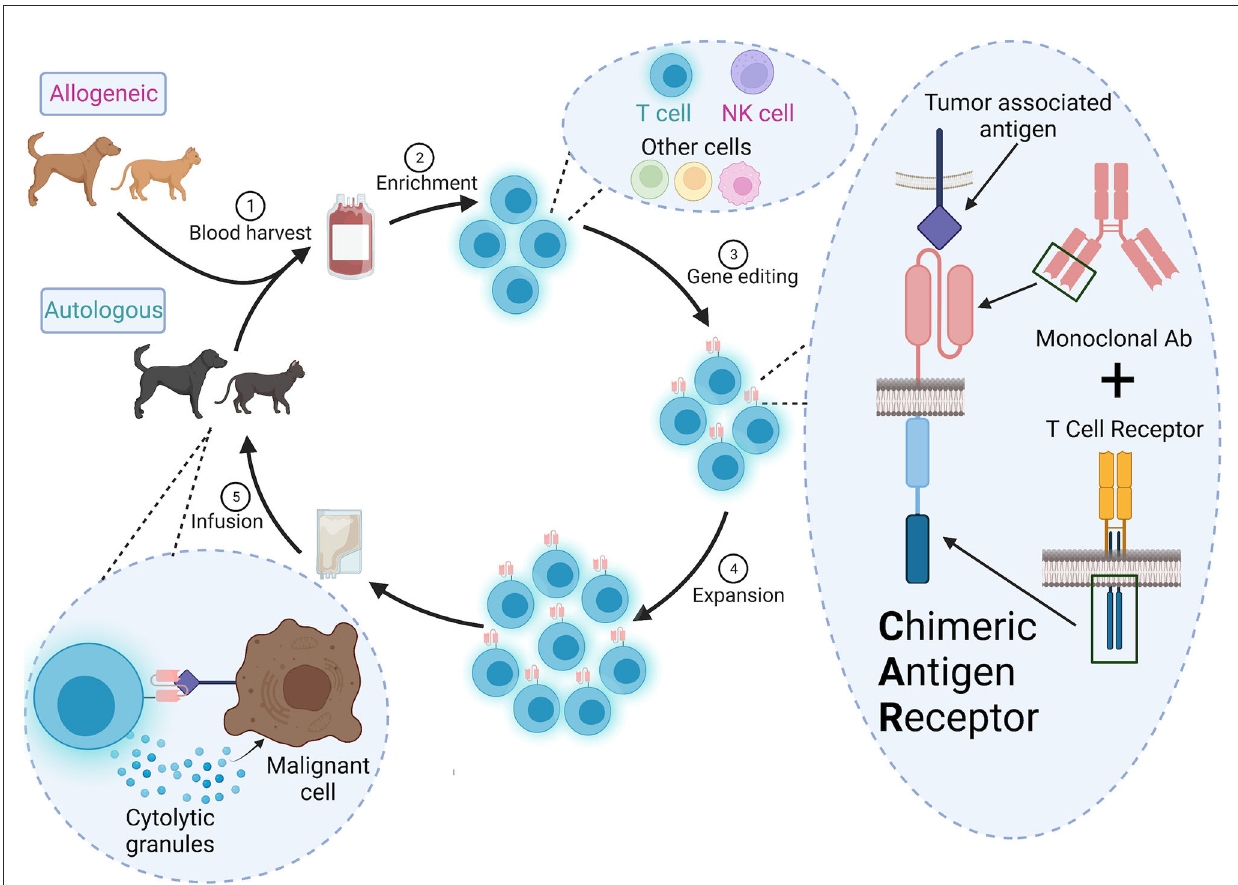
FIGURE1 Overall scheme for CAR therapy in veterinary medicine. (1) Autologous (from the patient) or allogeneic (from a donor) cells are harvested from peripheral blood or apharesis, (2) enriched and (3) engineered to a express a CAR ex vivo . The CAR contains the variable heavy and light chains of a monoclonal antibody specific for a tumor-associated antigen and signaling domains from the TCR signaling complex. (4) The CAR + cells are expanded to a clinically relevant dose and (5) infused into the patient. These CAR cells will detect and destroy cells expressing the target